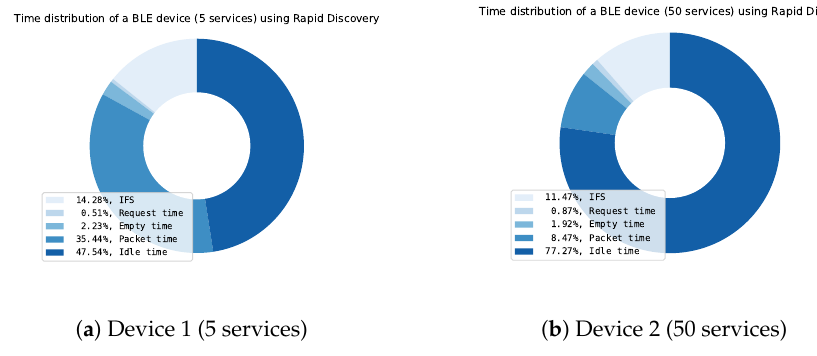
Figure 19. Time distribution of the RSDP of two devices: ( a ) Device 1 and ( b ) Device